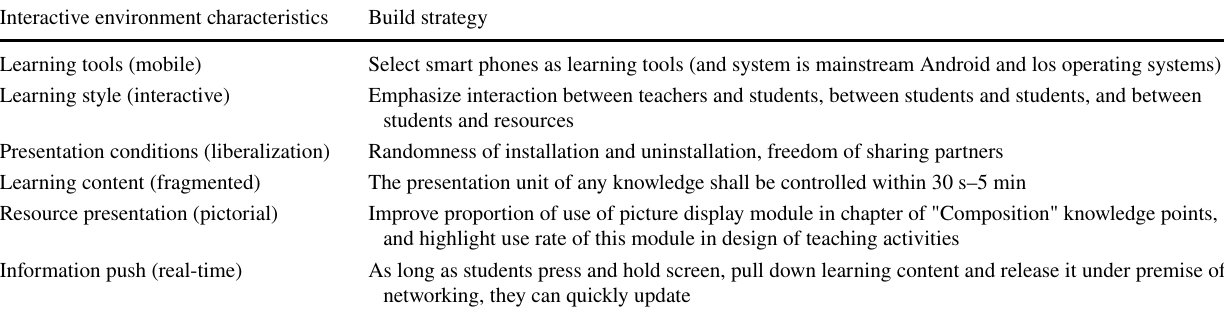
Table 1 Strategy for building a learning environment for smartphones Interactive environment characteristics